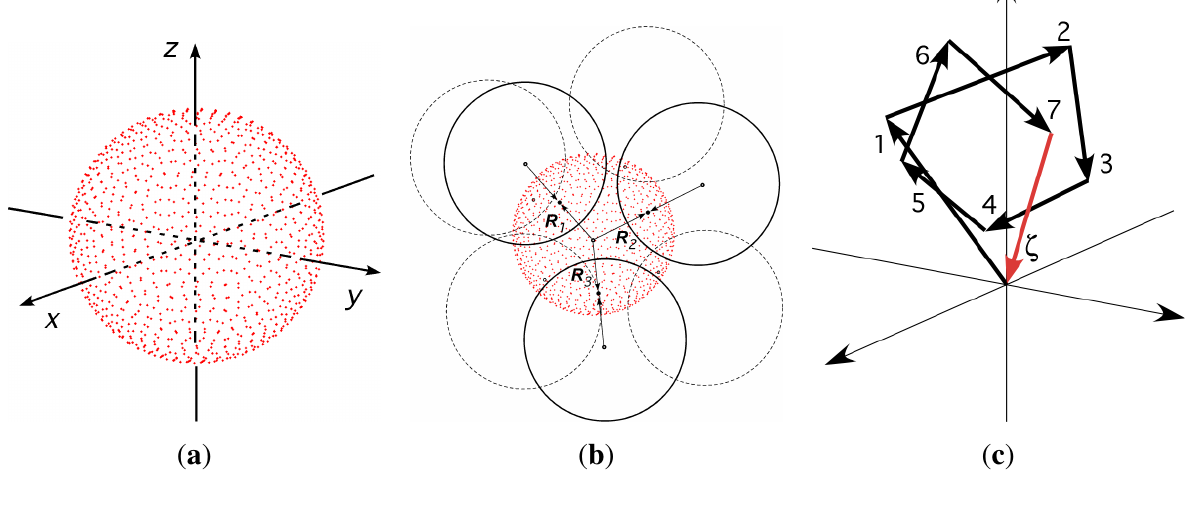
, R ) ≤ π . i j , R , ζ . ..., R 1 2 k